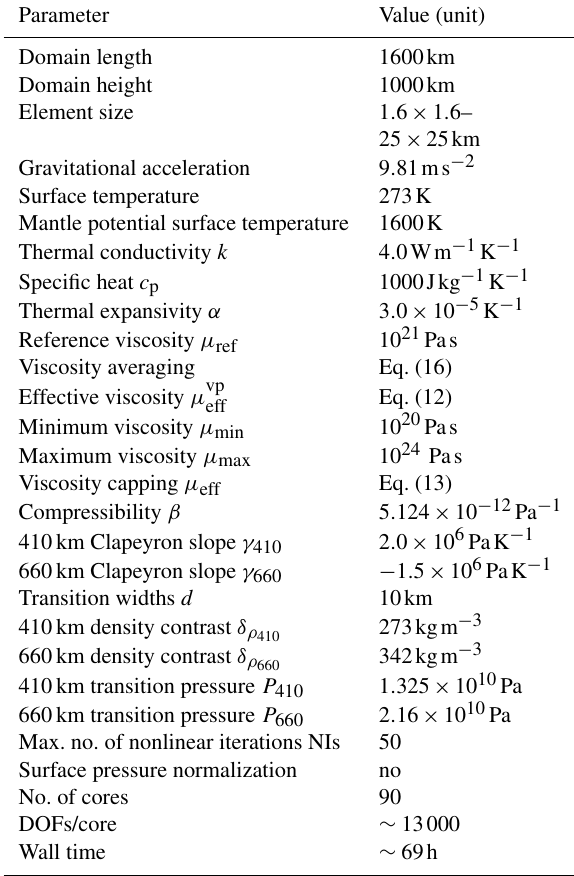
Table B1. Compressible subduction model parameters.